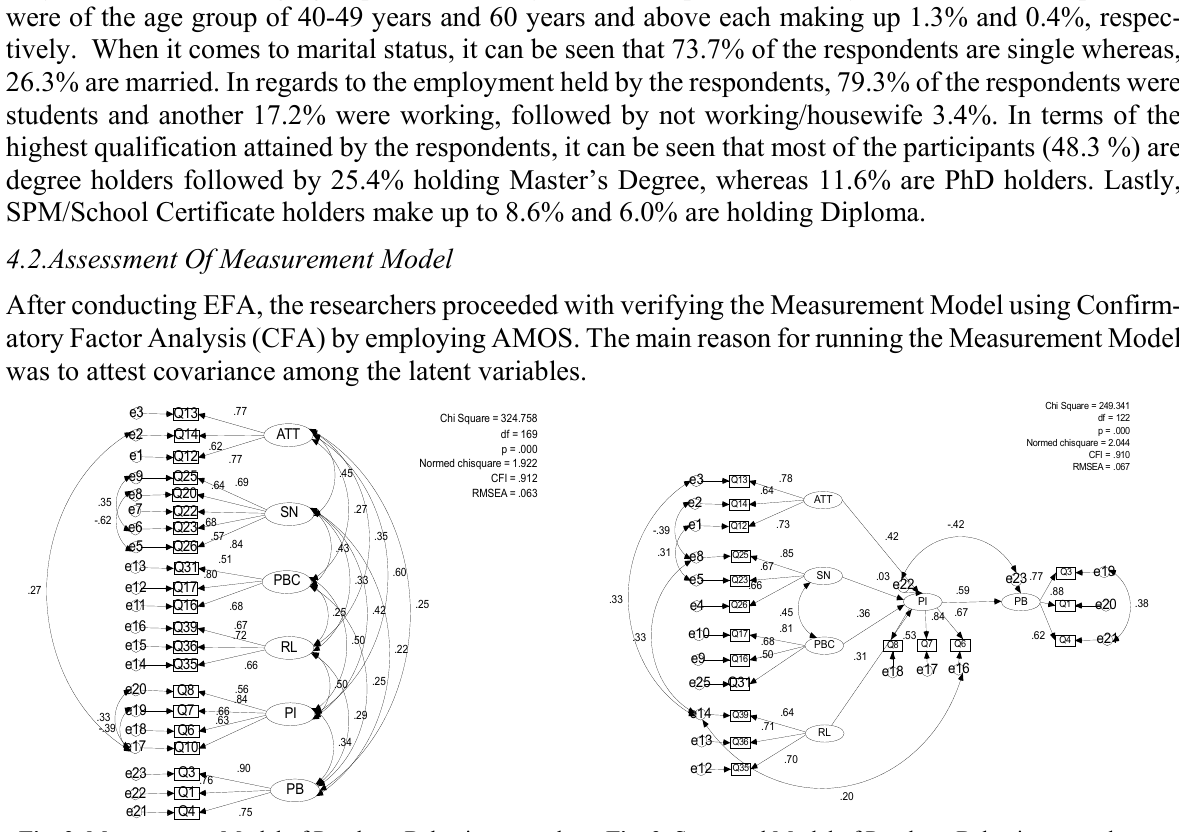
Fig. 2. Measurement Model of Purchase Behavior toward Halal Cosmetic Products